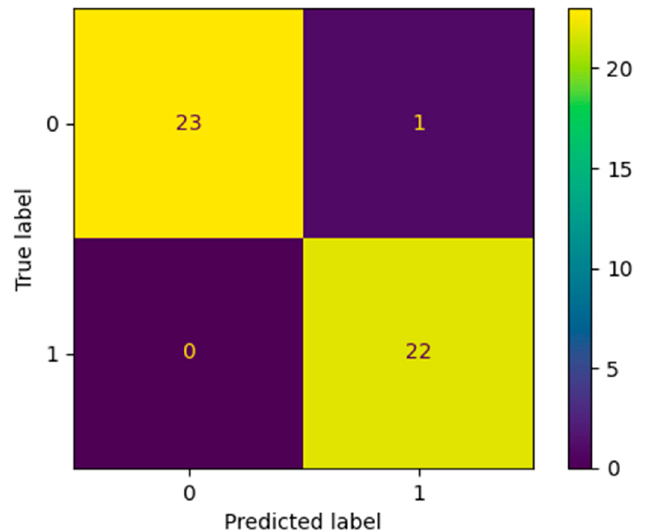
Figure 3. Glioma grading AUC values for the model predictions. Diffusion metrics from the DKI values were used to create model predictions of having a pLGG or a pHGG. ROC tests of the estimated probabilities of the DTI (red curve), DKI (green curve), and combined (DKI + DTI, blue curve) predictive model yielded AUC values of 0.859 (95%CI: 0.752–0.966), 0.939 (95%CI: 0.879–1), and 0.946 (95%CI: 0.889–1), respectively. pHGG: pediatric high-grade gliomas; pLGG: pediatric low-grade gliomas; DKI: diffusion kurtosis imaging.